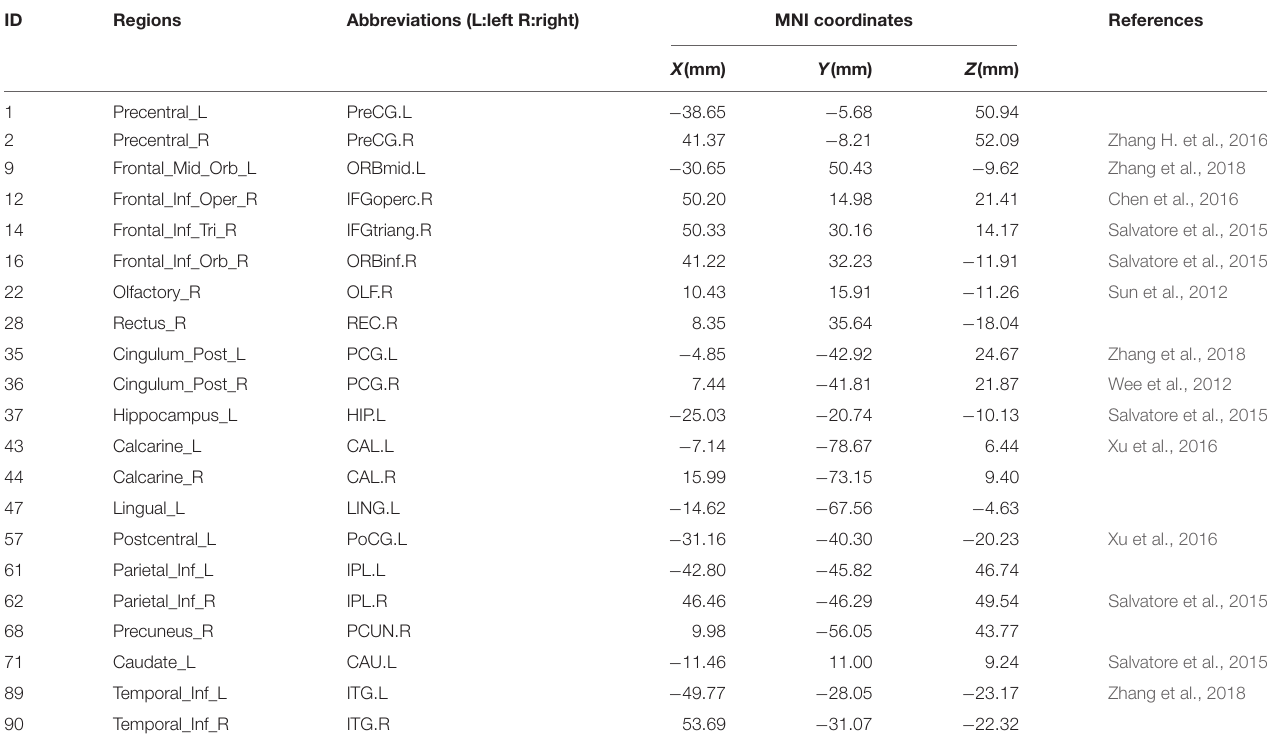
TABLE 6 | Discriminative brain regions. Regions Abbreviations (L:left R:right) MNI